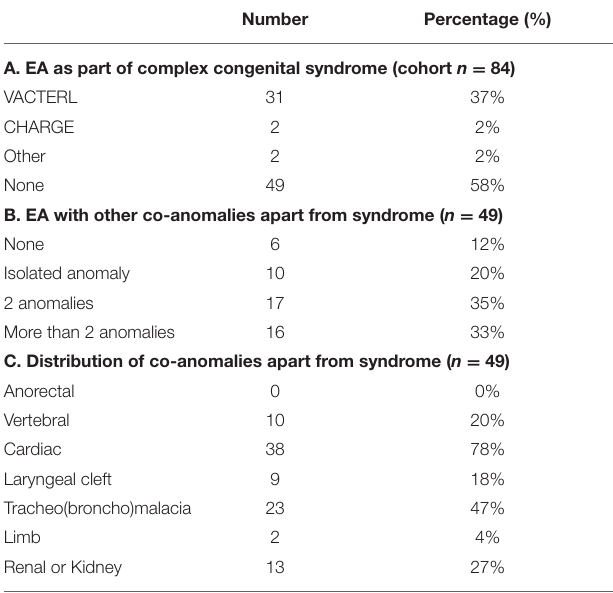
TABLE 1 | Incidence of esophageal atresia in the context of other congenital